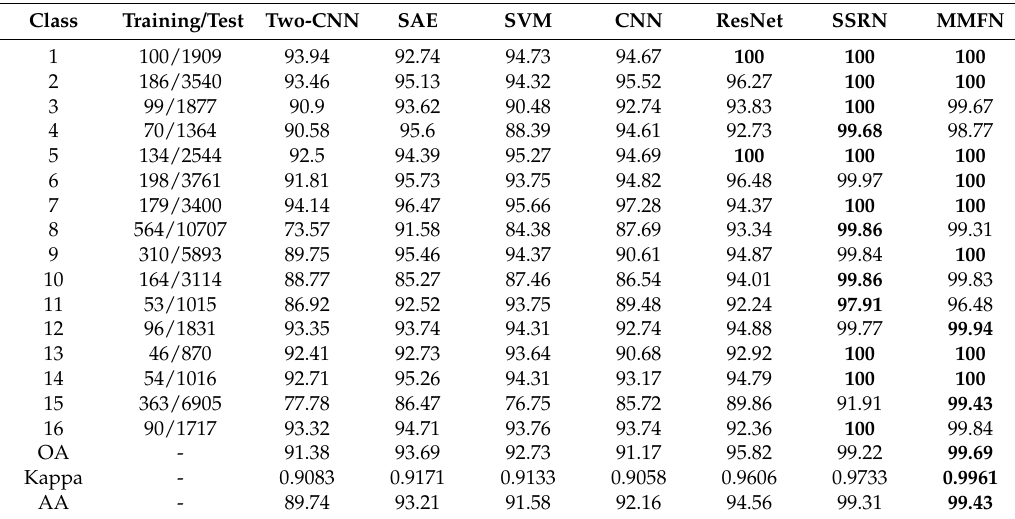
Table 12. Class-specific accuracies (%) of the Salinas Data